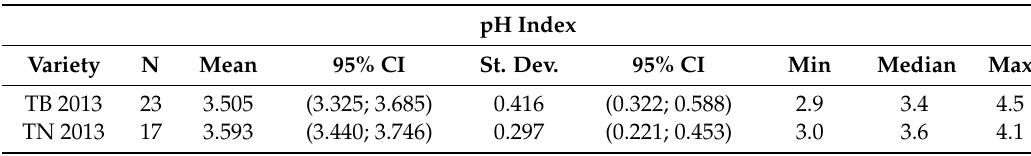
Table A11. Descriptive statistics of the samples used in the external test sets to further study the generalization capacity for the prediction of the pH